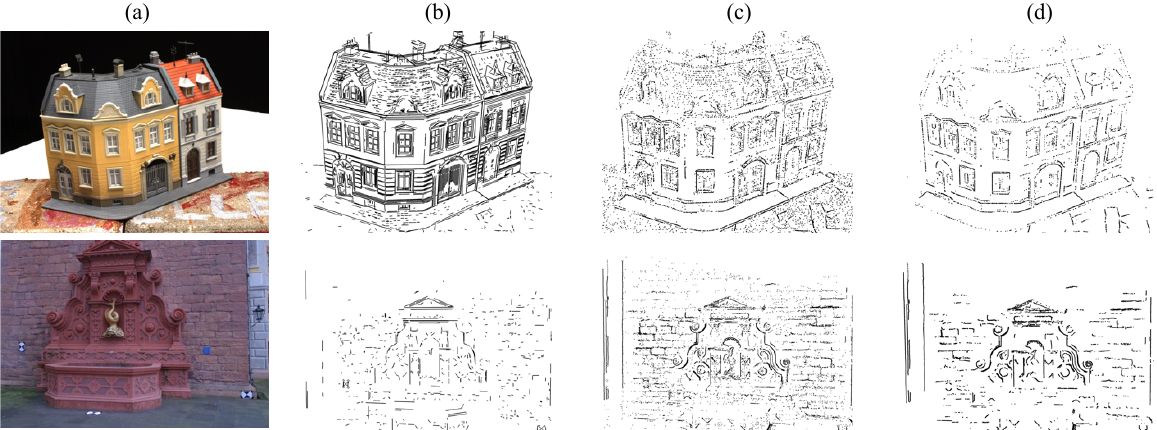
Figure 1 . Two examples of extracted 3D edges: Line3D++ (b), EdgeGraph3D - standard output (c) and EdgeGraph3D - isolated edge points (d). Line3D++ generates line segments, whereas EdgeGraph3D by default generates points along the edges fused with the input sparse point